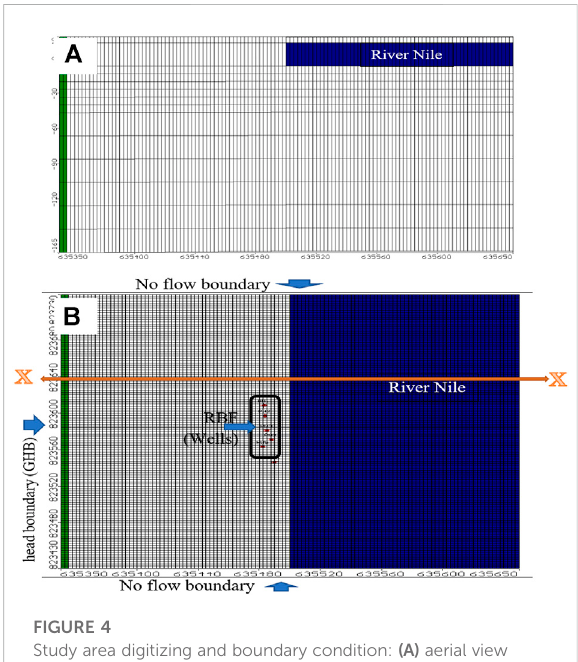
FIGURE 4 Study area digitizing and boundary condition: (A) aerial view and (B) section in X-X